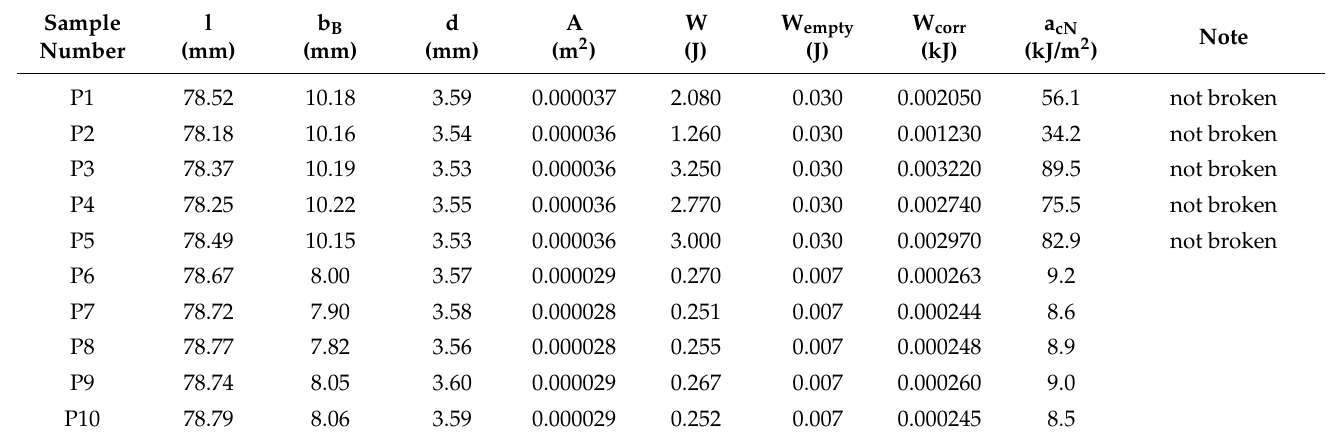
Table A9. Results of the notched impact tests and unnotched impact tests of P_W,C,PE.